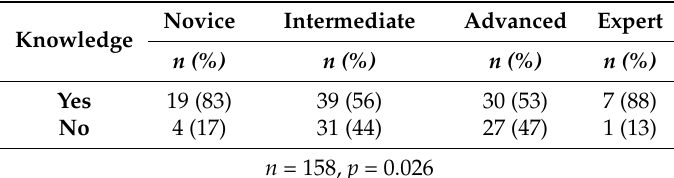
Table 6. Detection accuracy by knowledge level (no attack).